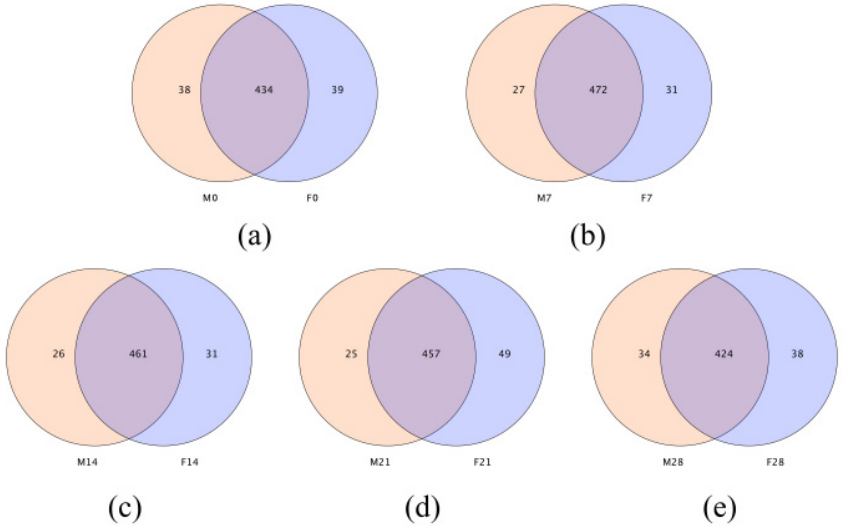
Figure 2. OTU-based Venn diagram analysis: the effect of different protein sources for fish meal substitution on the fecal flora of blue foxes. ( a ): Venn diagrams of the fecal flora between M0-vs-F0; ( b ): Venn diagrams of the fecal flora between M7-vs-F7; ( c ): Venn diagrams of the fecal flora between M14-vs-F14; ( d ): Venn diagrams of the fecal flora between M21-vs-F21; ( e ): Venn diagrams of the fecal flora between M28-vs-F28.